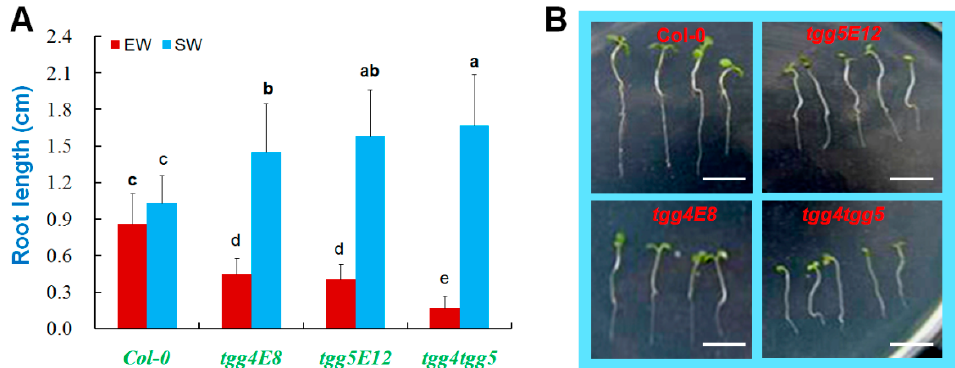
Figure 7. Root growth of AtTGG4 and AtTGG5 mutants in soil with excessive water. ( A ) Analysis of root length grown in soil with excessive water (EW) and sufficient water (SW) for two weeks after sowing; different letters above columns indicate significance at 5% significant level; and ( B ) representative seedlings of the four genotypes grown in soil with excessive water for two weeks after sowing; scale bars represent 5 mm.